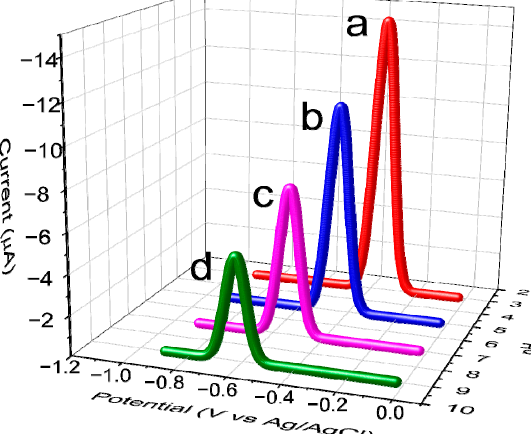
Figure 8. DP voltammograms obtained from the application of 100 μ mol L − 1 MTX at different pH levels of PBS. Range of pH investigated: 3 ( a ), 5 ( b ), 7 ( c ), and 9 ( d ).